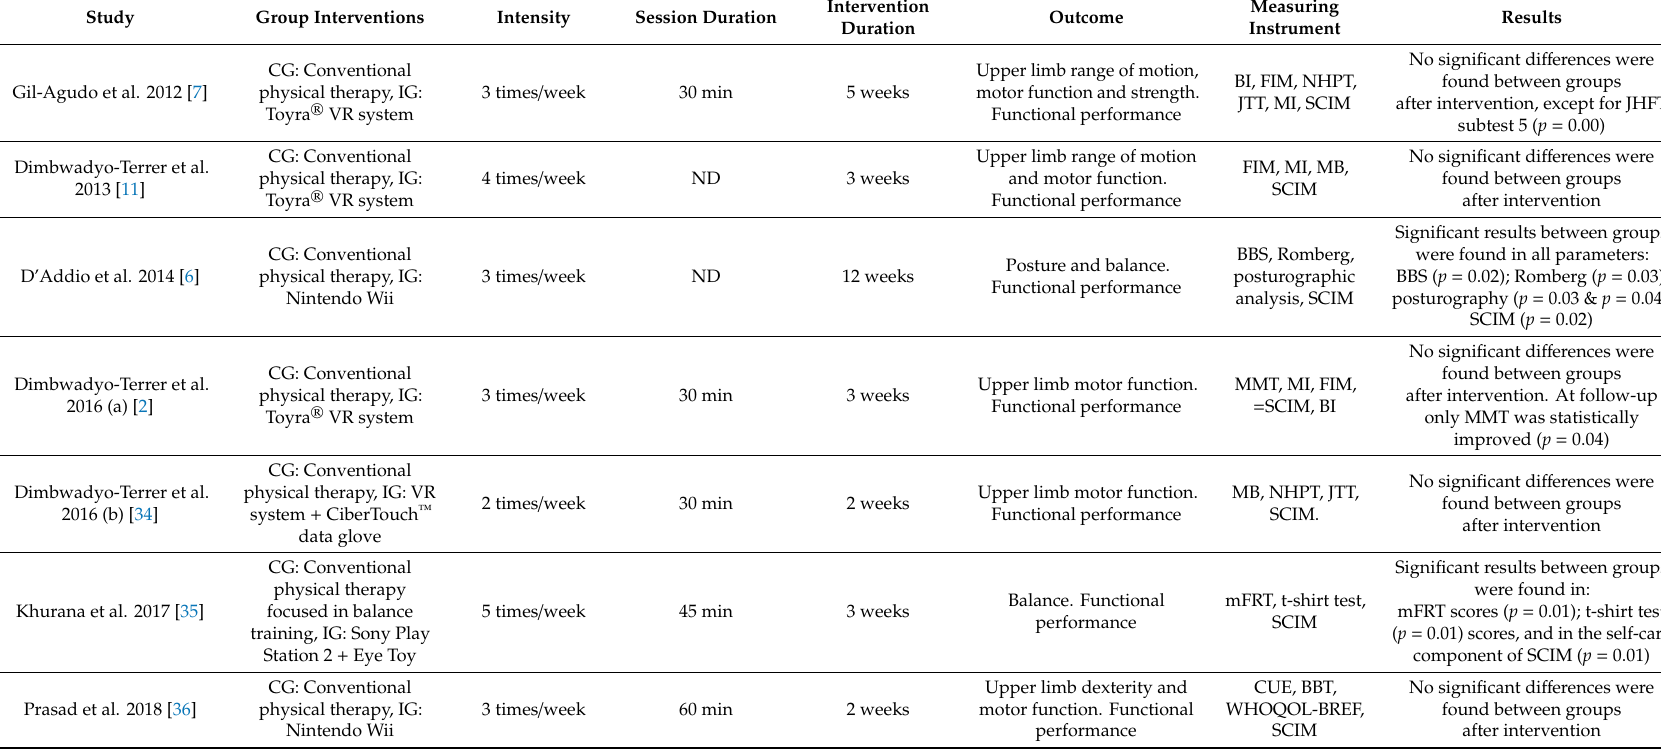
Table 3. Main characteristics of the